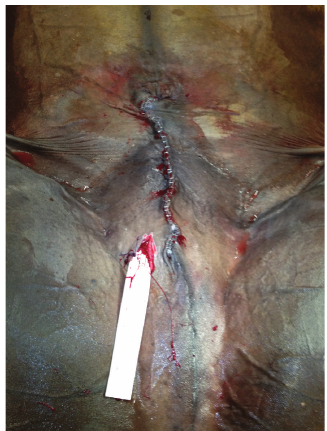
Figure 2: Abdominal wall suture and a multitubular drain applied at the scrotal region.